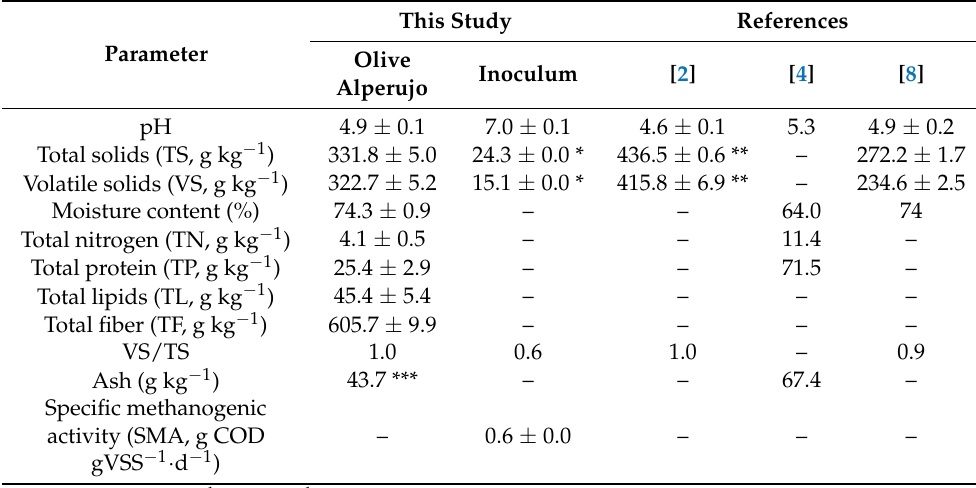
Table 1. Physicochemical characterization of the raw olive alperujo (substrate) and the inoculum used in this study (average value ± standard deviation